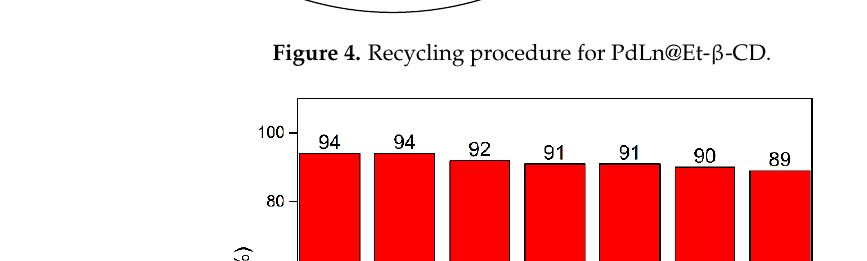
Figure 4. Recycling procedure for PdLn@Et ‐β‐ CD.